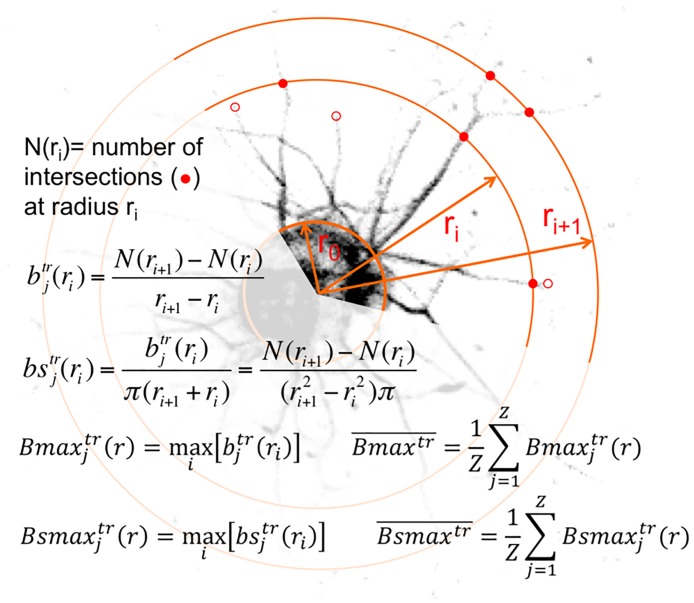
Definition of data used for the Sholl analysis and mathematical formulas used for the estimation of neurite branching based on the Sholl profiles.Red filled circles indicate intersections at the generic radius ri and ri+1, whereas red empty circles indicate terminating neurites between two successive radii. (j) = neuron; (tr) = treatment; (i) = generic radius number; N(ri) = number of intersections at radius ri; N(ri+1) = number of intersections at radius ri+1; (bjtr(ri)) = branching rate; (bsjtr(ri) = specific branching; (Bmaxjtr(r)) = maximum branching; (Bsmaxjtr(r)) = maximum specific branching.